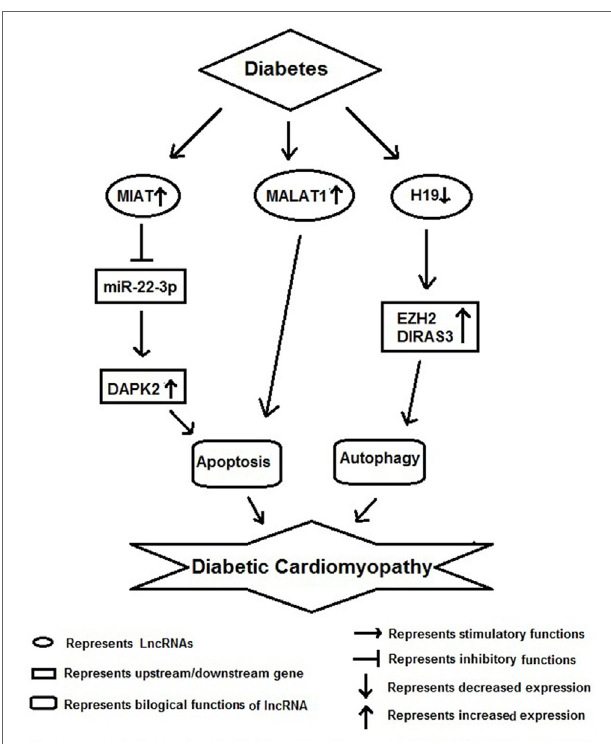
FiGURe 4 | Schematic model showing functional role of long non-coding RNAs (lncRNAs) in diabetic cardiomyopathy.